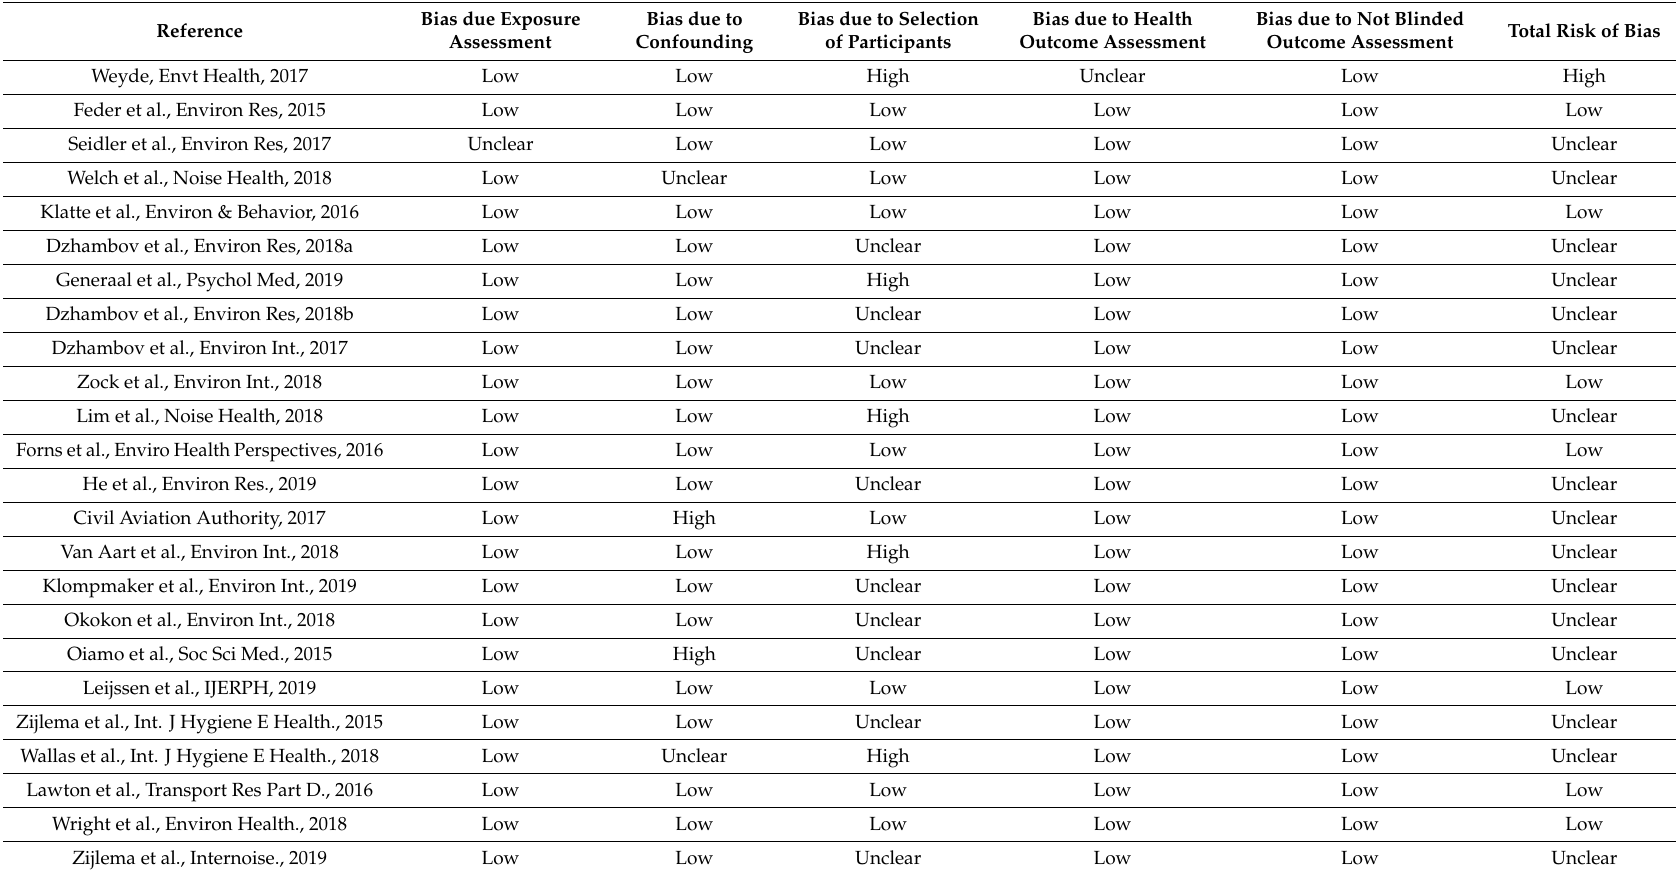
Table 2. Mental health, wellbeing and quality of life: risk of